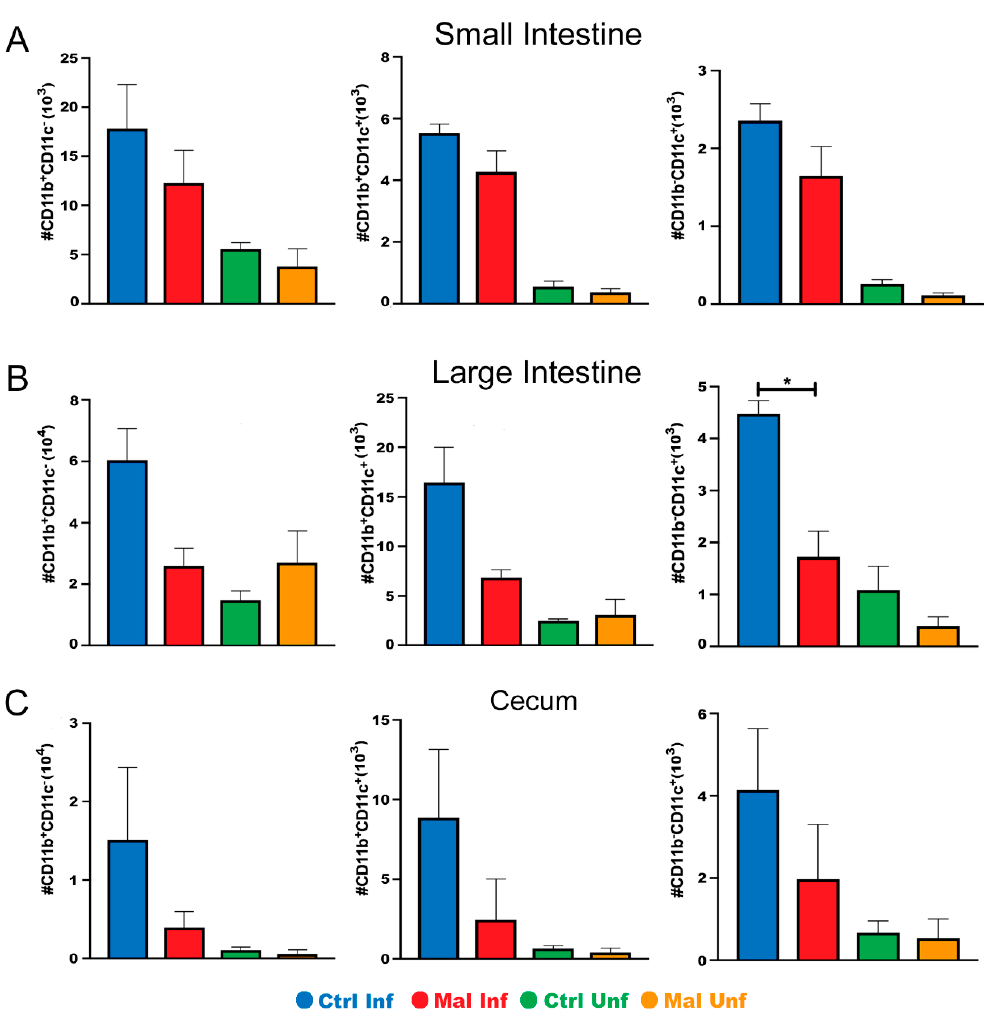
Figure 3. Moderately malnourished mice have lower numbers of innate immune cells in the gut during P. chabaudi infection. Flow cytometric analysis of surface staining for CD11b + CD11c - , CD11b + CD11c + , CD11b − CD11c + quantified cell numbers from the ( A ) small intestine, ( B ) large intestine, and ( C ) cecum of d9 P. chabaudi infected C57Bl/6 mice. Data are shown as means ± SE, n = 3 male mice per group, and is a representative of 3 independent experiments. Statistical analysis was performed using a two-way ANOVA followed by the Tukey’s test. * p < 0.05; indicates a statistically significant difference between treatments.